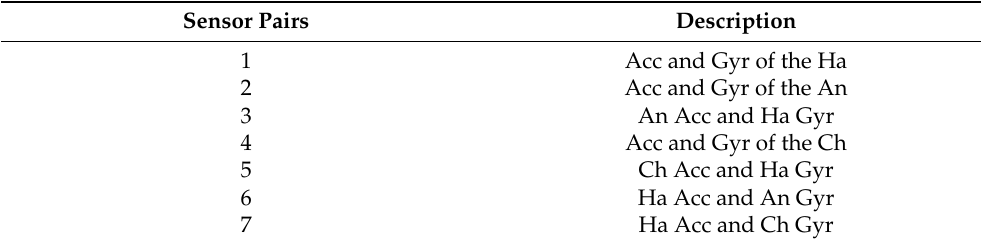
Table 2. Sensor used to extract the PAMAP2 datasets. Ha = Dominant arm , Ch = Chest, and An = Dominant side’s ankle.